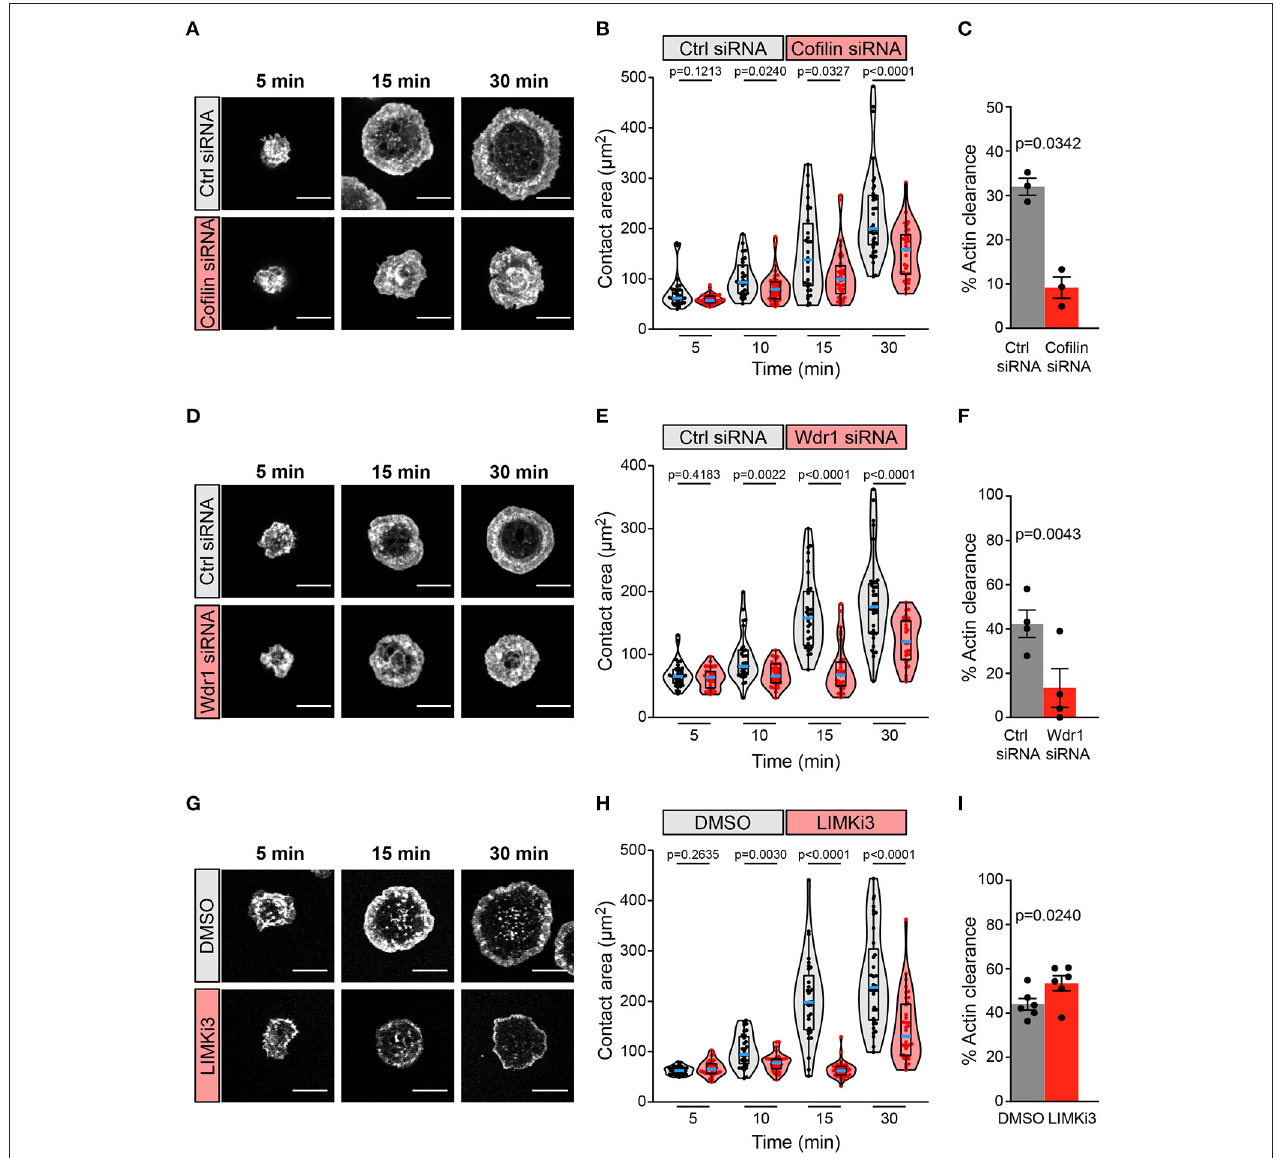
FIGURE 2 | The Wdr1-cofilin-LIMK axis regulates B-cell spreading on immobilized anti-Ig. A20 B cells were transfected with control (Ctrl) siRNA or cofilin siRNA (A–C) , transfected with control (Ctrl) siRNA or Wdr1 siRNA (D–F) , or pre-treated with DMSO or 50 µ M LIMKi3 for 1h (G–I) . The cells were then allowed to spread on anti-IgG-coated coverslips for the indicated times before being stained with rhodamine-phalloidin and imaged by confocal microscopy. Representative images are shown (A,D,G) . Scale bars: 10 µ m. In (B,E,H) the cell area was quantified using the actin staining to define the cell edge. Each dot in the beeswarm plots represents one cell and the median (blue line) and interquartile ranges (black box) for > 30 cells are shown for each time point. Representative data from one of three (B) , four (E) , or six (H) independent experiments are shown. p-values were determined using the Mann-Whitney U test. In (C,F,I) the percent of the total cell area at the substrate contact site that was cleared of F-actin after 30min was quantified by using the actin staining to define both the outer cell edge and the inner face of the peripheral actin ring that surrounds the central actin-depleted region of the cell (see Supplementary Figure 1 for examples). For each experiment, the median percent actin clearance was determined for each treatment group. Representative experiments are shown in Supplementary Figure 1 . The bar graphs show the means ± SEM for these median values from three (C) , four (F) , or six (I) independent experiments, each of which is represented by a dot. p-values were determined using a two-tailed paired t